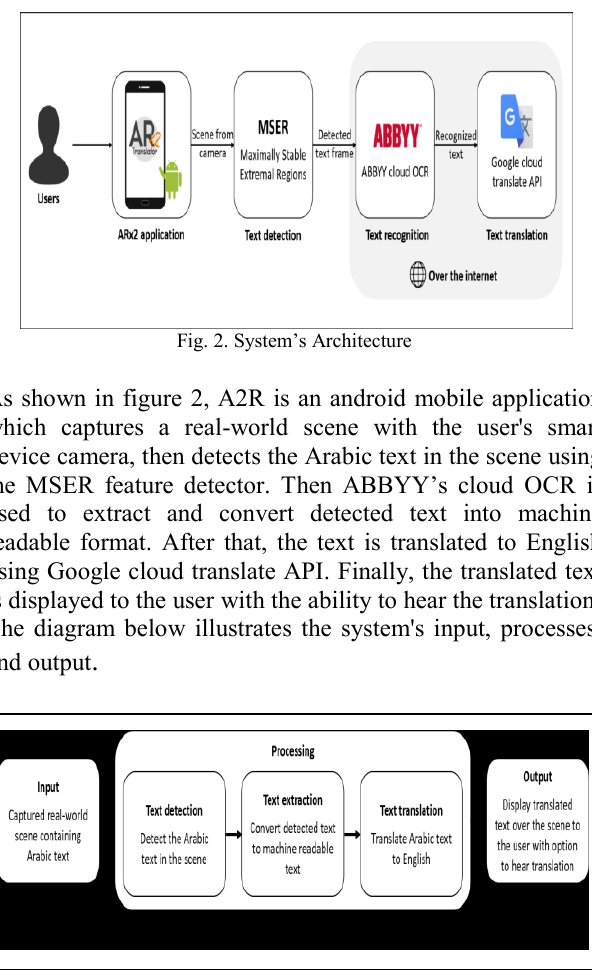
Fig. 3. Input, processes and output